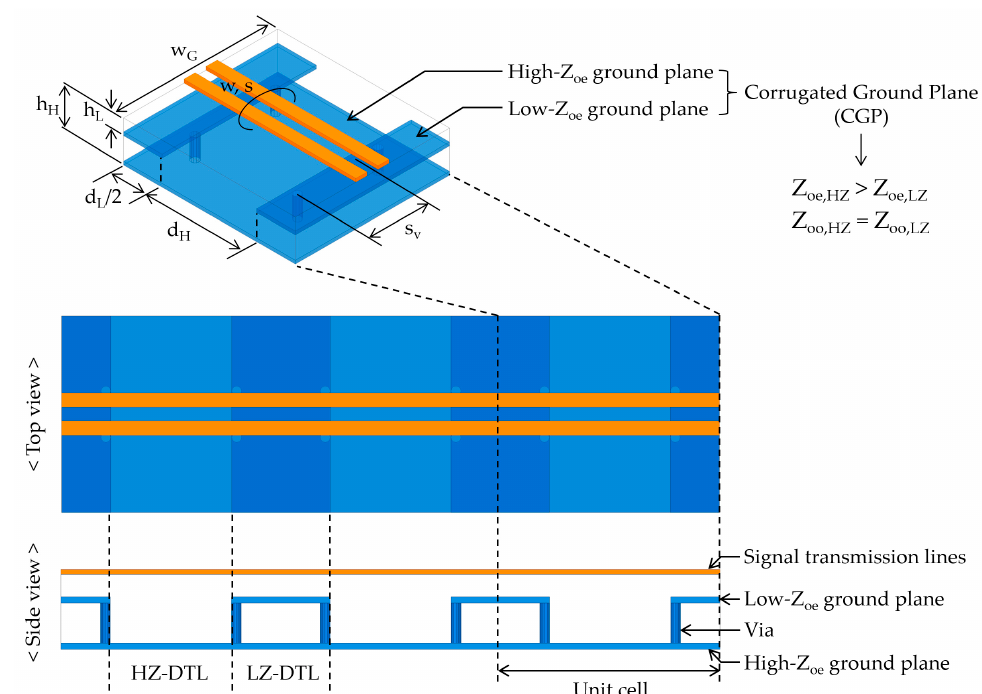
Figure 1. Schematic of a metamaterial differential transmission line (MTM-DTL) using a corrugated ground-plane electromagnetic bandgap (CGP-EBG) structure.